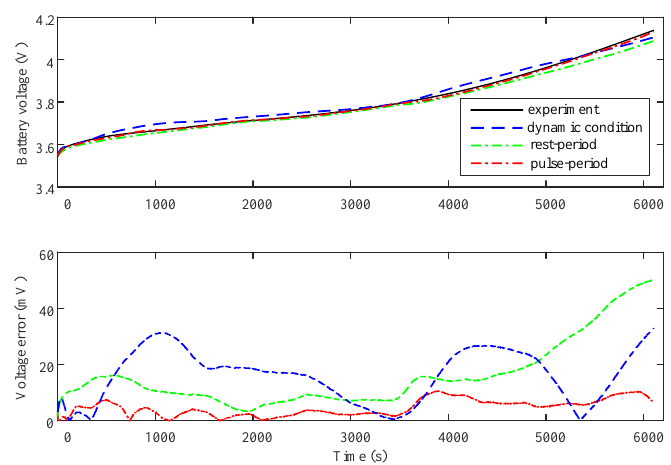
Figure 13. Verification results of different parameter estimation methods under the CC charging test. Table 4. RMSE of model voltage estimation under the CC charging test.